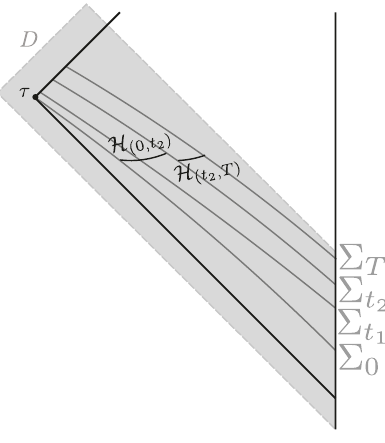
Figure 11 . An example of the construction of the manifold H [ τ ] outside a past well-behaved trapped surface τ . Σ t is a one-parameter family of spatial slices, and both H spacelike manifolds foliated by marginally outer trapped surfaces. H [ τ ] can be taken to be